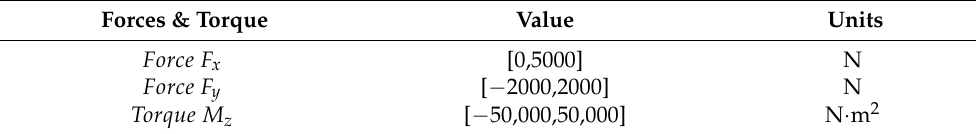
Table 2. Limits of Control Forces and Control Torque.